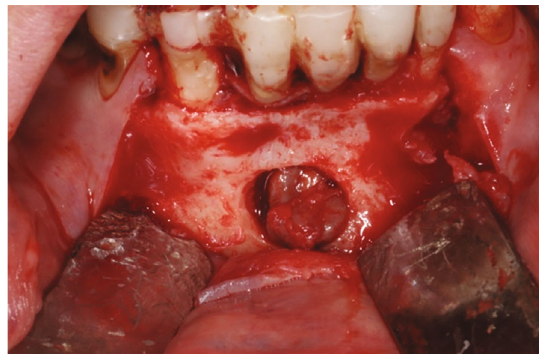
Figure 5: Vision of the vestibular bone